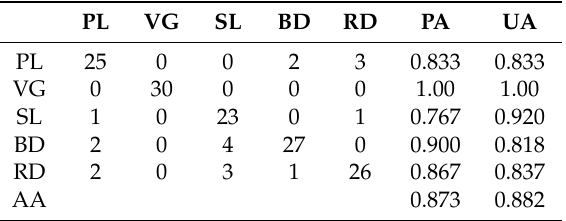
Table 9. Confusion matrix of the proposed method in the third area.